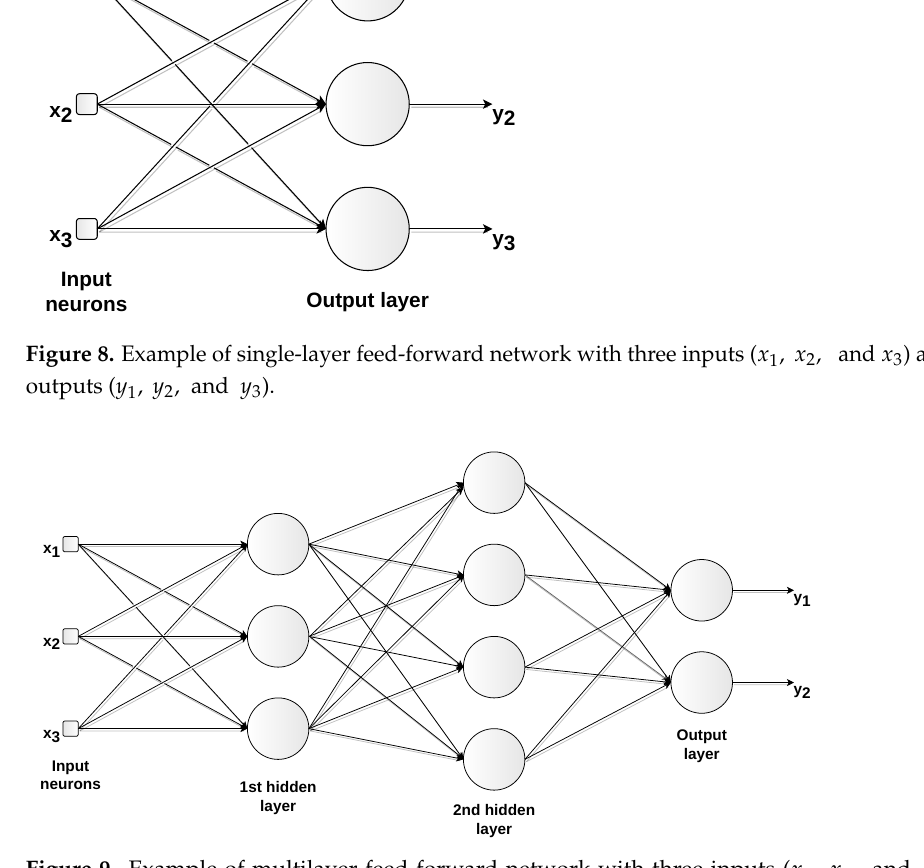
Figure 9. Example of multilayer feed-forward network with three inputs ( x 1 , x 2 , and x 3 ), two hidden layers, and two outputs ( y 1 and y 2 ).